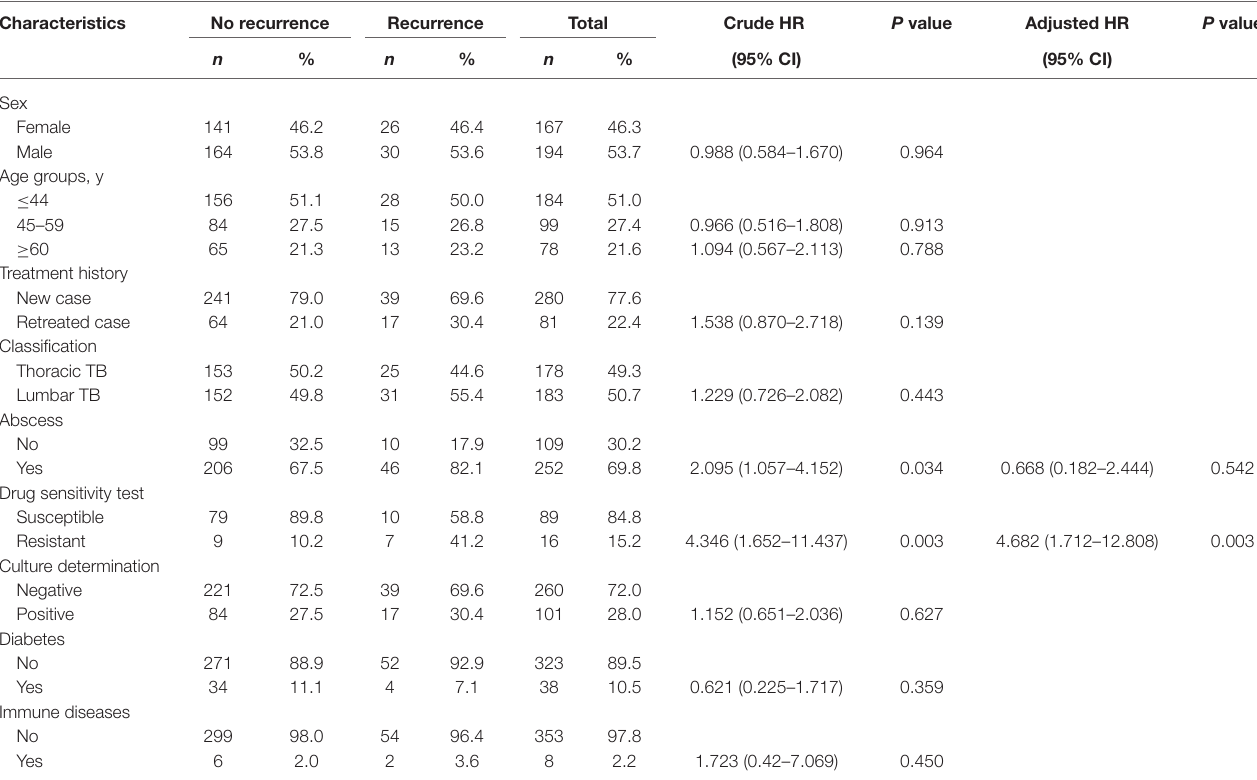
TABLE 2 | Risk factors for recurrence among Spinal Tuberculosis in the study. Characteristics